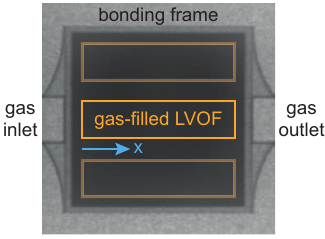
Figure 6. Top-view image of the fabricated device captured by a near-infrared